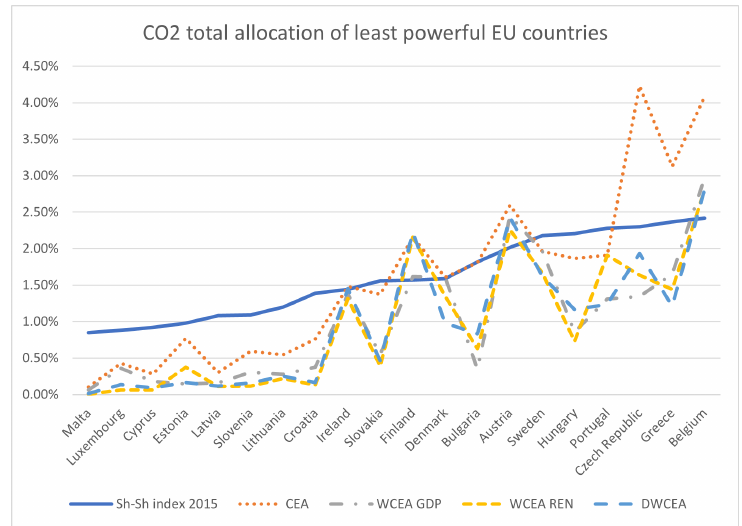
Figure 3. Percentages of total CO 2 emission permits for EU countries with Sh–Sh power index strictly smaller than 3% for the four allocation rules considered in this paper. Countries are ordered according to the Sh–Sh power index (solid